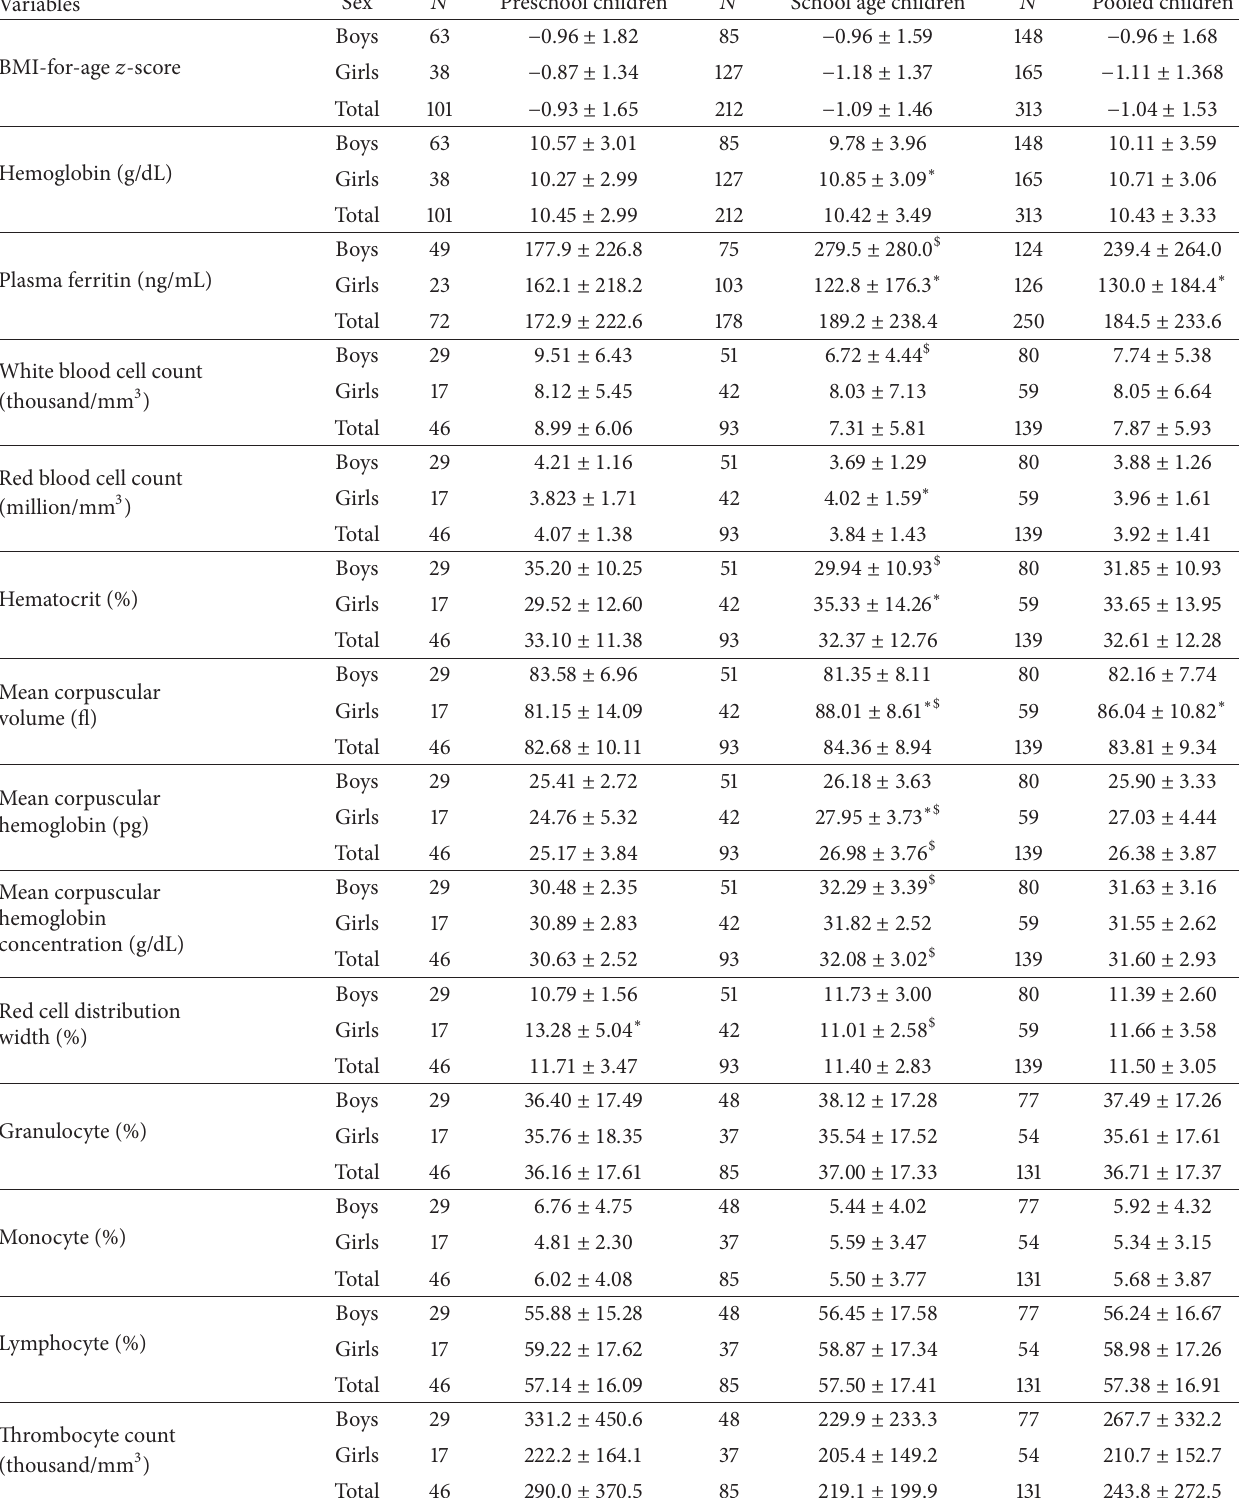
Table 3: Mean BMI-for-age 𝑧 -score and hematological parameters among children in Odisha, India. Variables Sex 𝑁 Preschool children 𝑁 Pooled